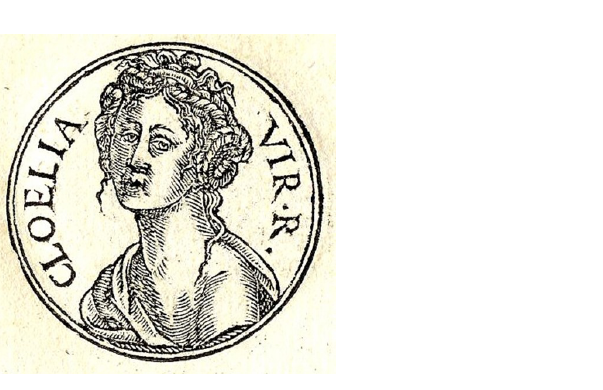
Figure 4. Insignia of Clelia “Promptuarii Iconum Insigniorum”. Guillaume Rouille 1553.